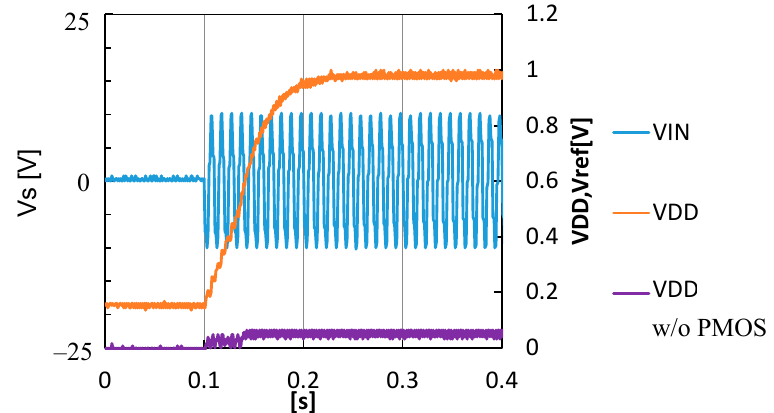
Figure 10. Measured waveform with and without P PD .